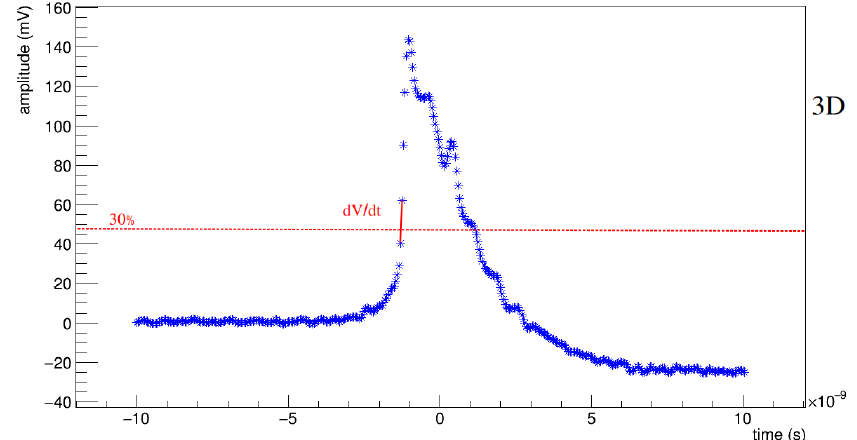
Figure 6. Example of 1000 averaged waveforms for the 3D